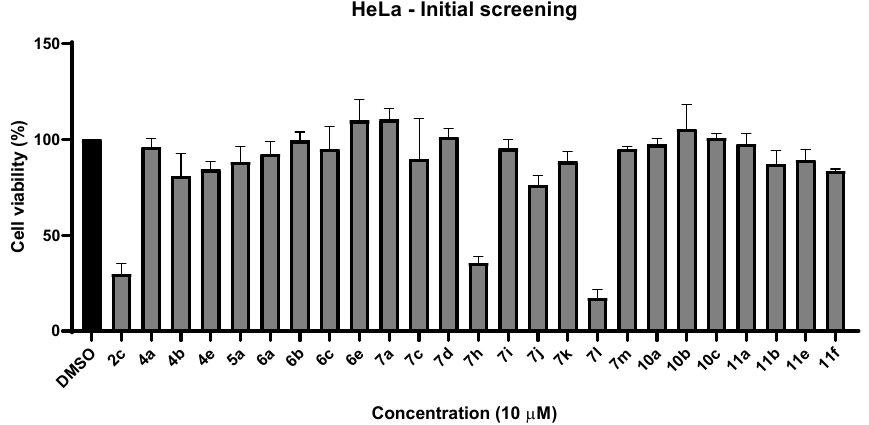
Figure 4. Initial screening results for HeLa cells after 72 h incubation.